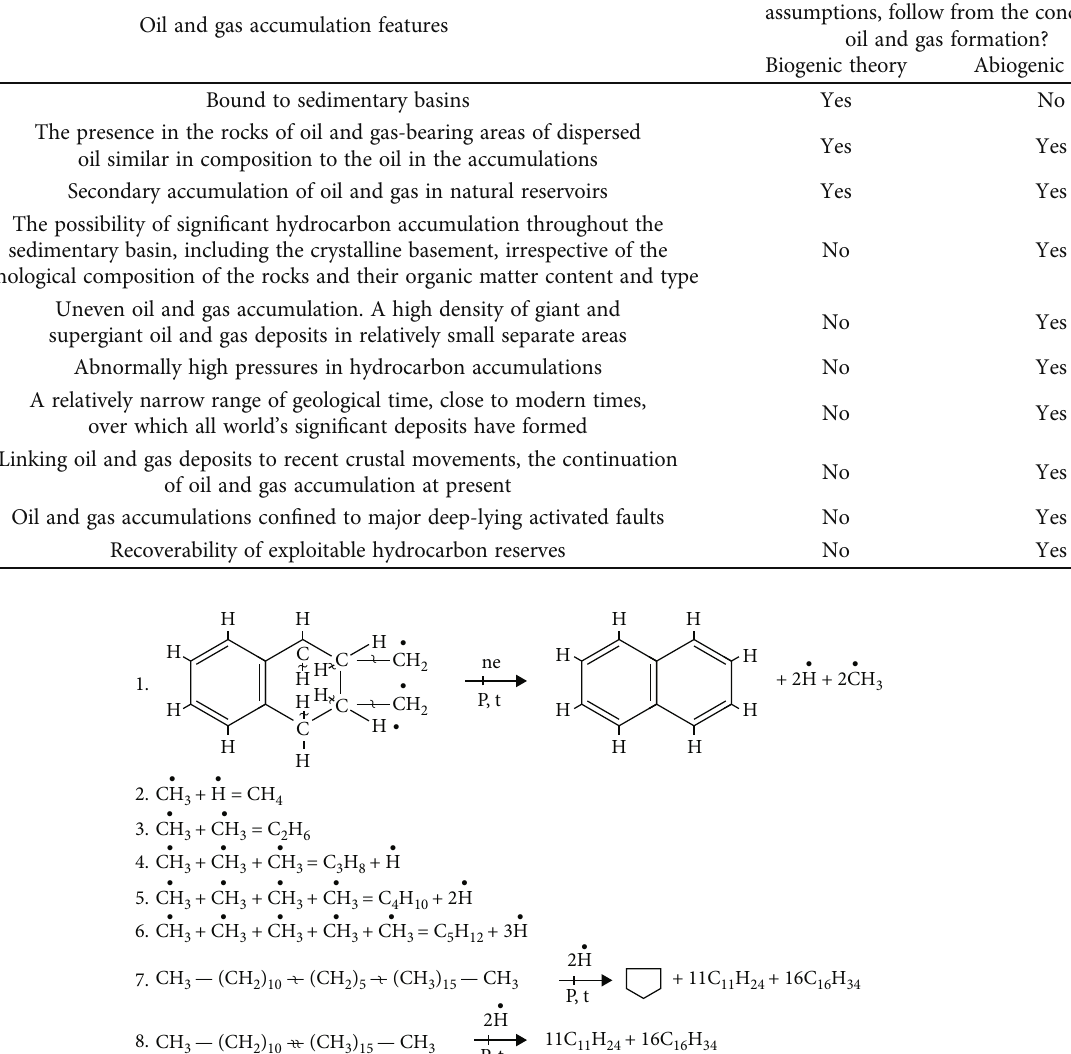
Table 1: Peculiarities of oil and gas formation (by Yu.I.Pikovsky, supplemented by the authors) [15]. Oil and gas accumulation features